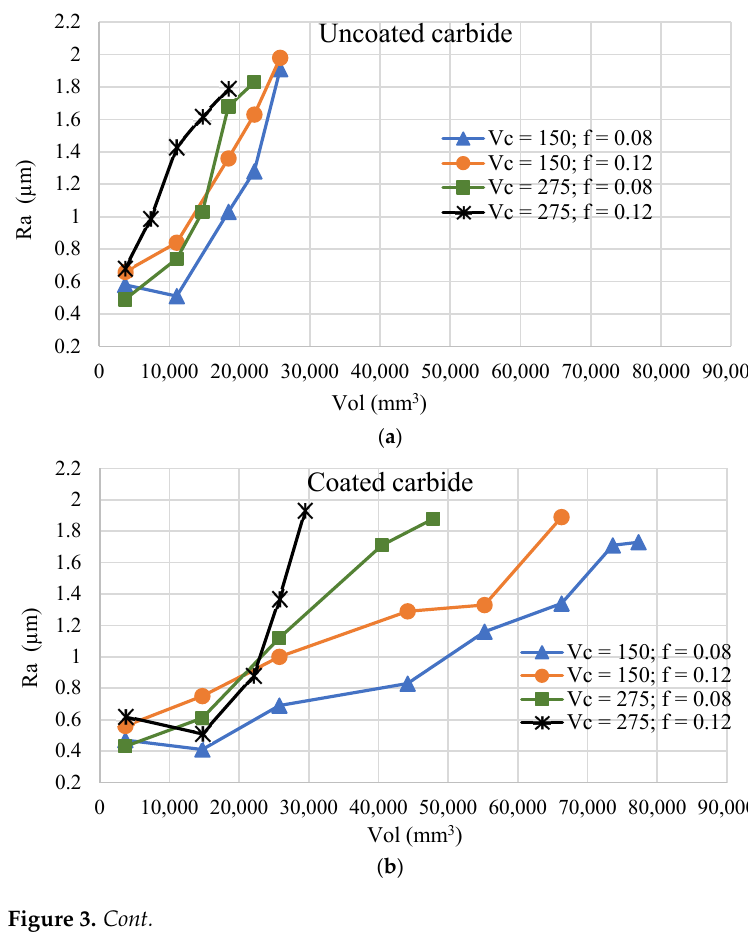
Figure 2. Progress of tool’s flank wear with volume of work material removed, categorized with respect to the three cutting inserts used in the experiments: ( a ) uncoated carbide; ( b ) coated carbide; and ( c ) CBN. V c and f are represented in m/min and mm/rev, respectively.